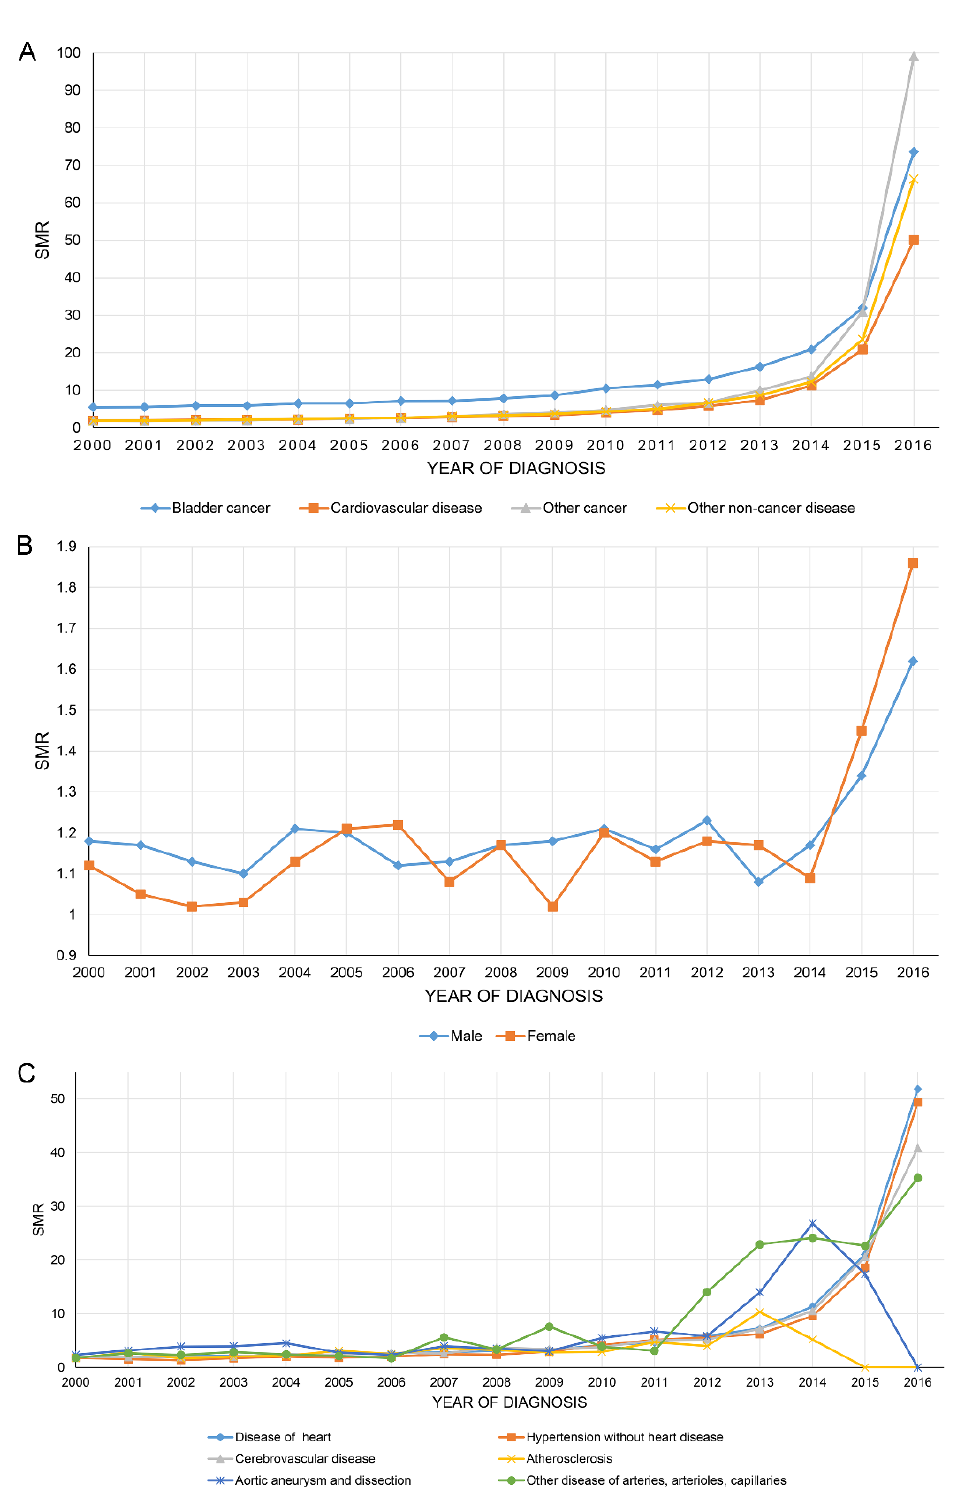
Figure 3. The overall standardized mortality ratio (SMR) of all causes of death of bladder cancer patients increased year by year ( A ). SMR in cardiovascular disease stratified by sex ( B ) and all causes of cardiovascular mortality ( C ).